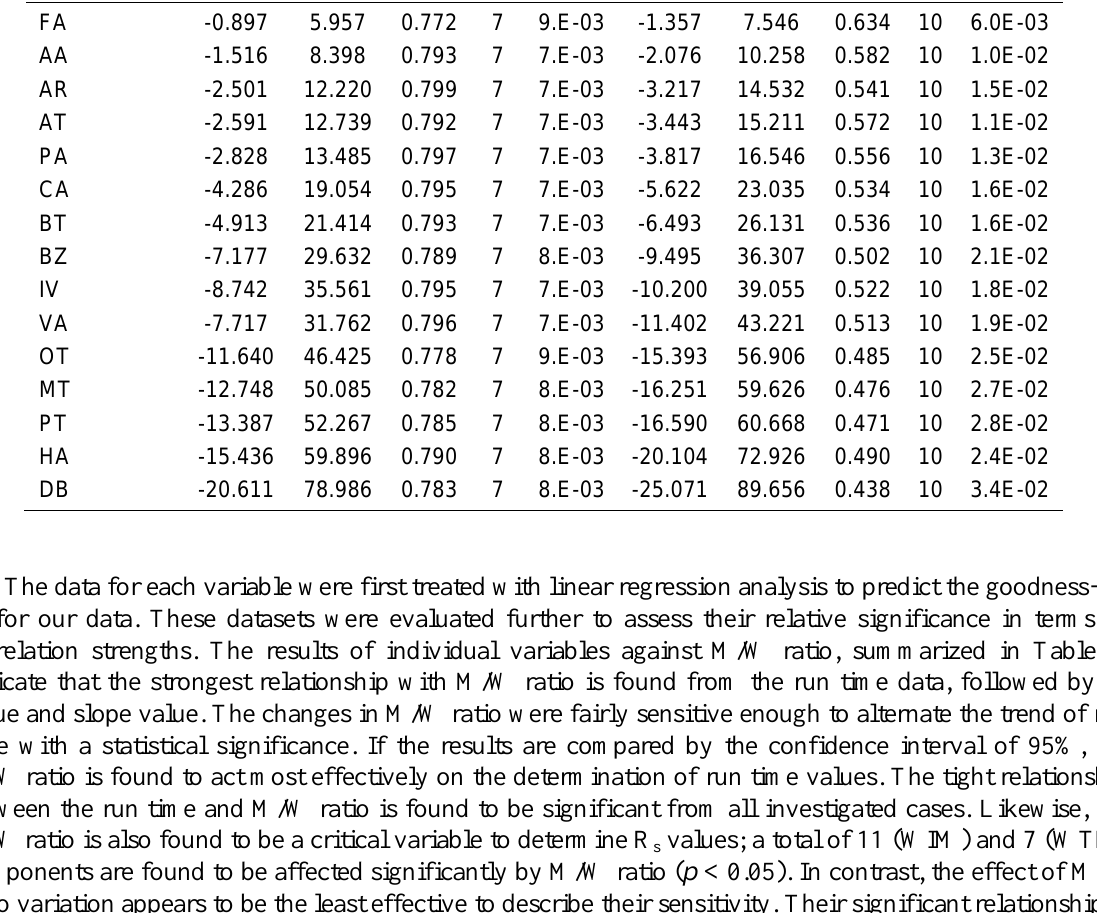
their separation based on ternary mobile phases. To this end, three types of ternary mobile phases (i.e., WIM, WTM, and WIT) were initially designed and tested in reference to a standard binary mixture (ACN:water). The results indicate that the separation of CCs can be archived in a narrow range of water composition (30 to 35%) in terms of maximum number of quantifiable CCs. The sensitivity of the